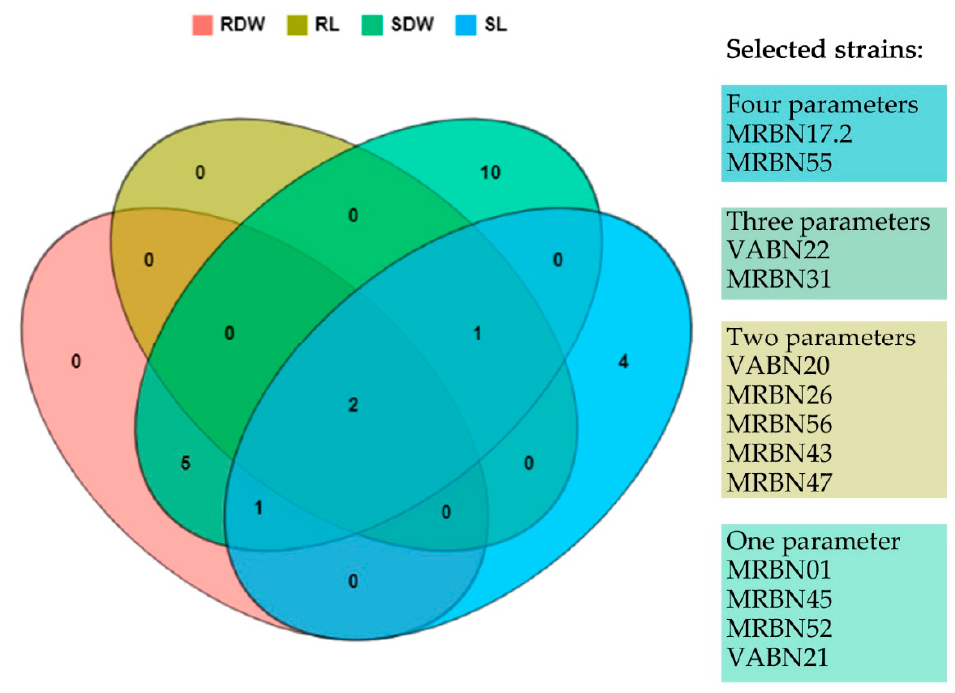
Figure 1. Four-set Venn diagram showing the number of canola endophytic isolates whose inoculation significantly increased at least one of the following growth parameters: SDW, shoot dry weight; RDW, root dry weight; SL, shoot length; RL, root length. The bacterial isolates selected for the microcosm assay are listed at the right of the figure.